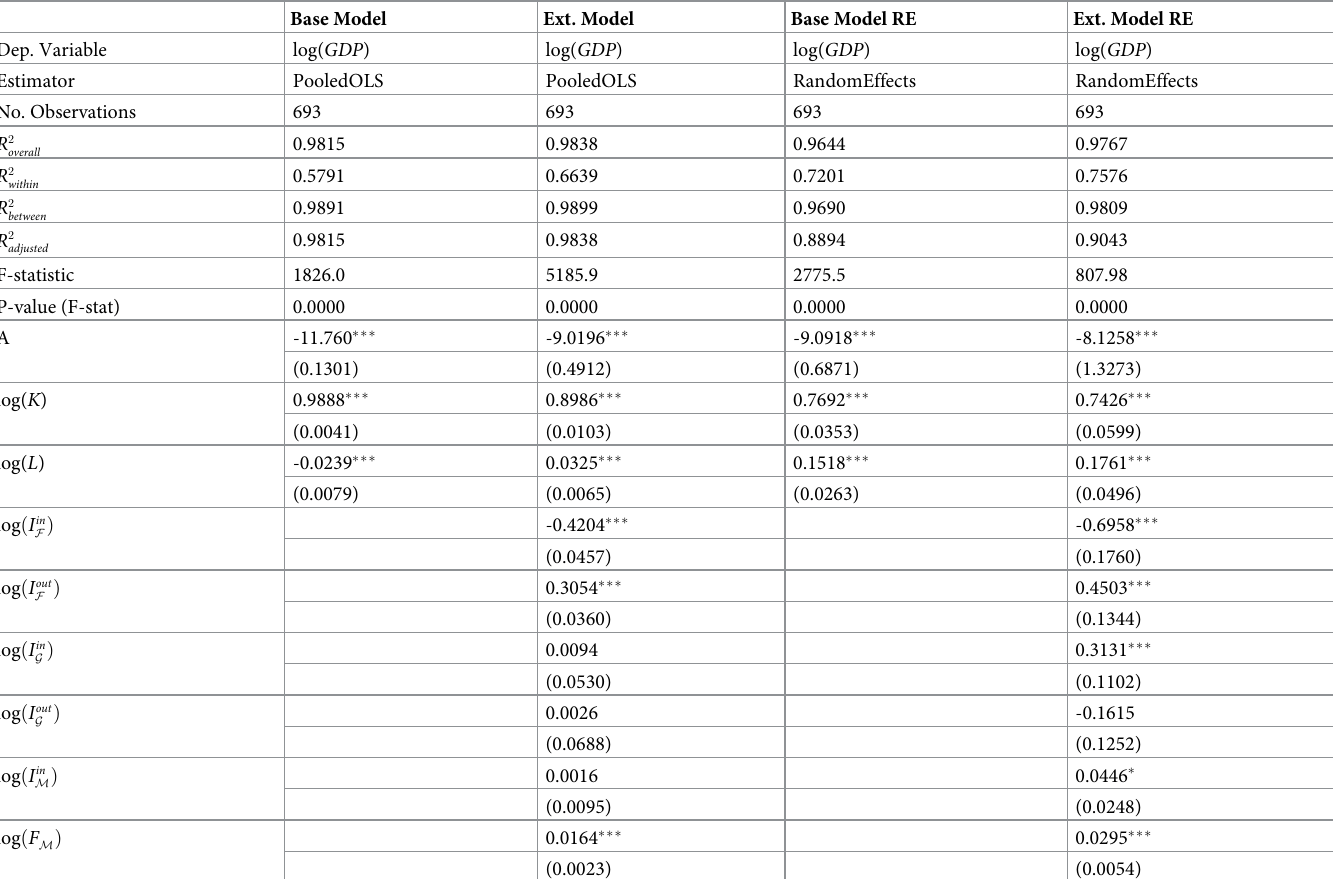
, R 2 , R 2 , R 2 and overall within between adjusted